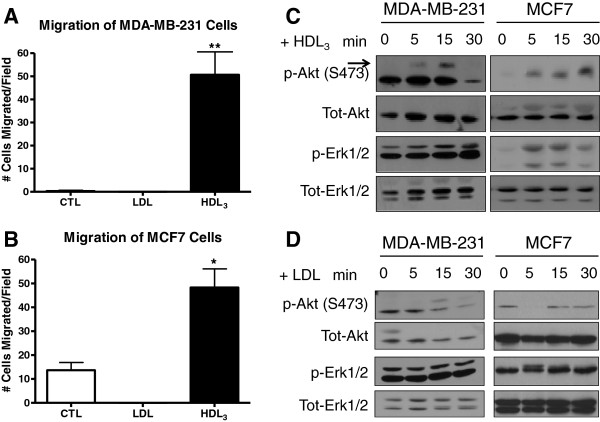
HDL3 induces migration and acts as a signaling molecule in MDA-MB-231 and MCF7 cells.  Migration of MCF7 (A) and MDA-MB-231 (B) cells was induced by HDL3. Migration of MCF7 and MDA-MB-231 cells was increased when HDL3, but not LDL, was used as a chemoattractant compared with CTL (1% BSA alone) in Boyden Chamber assays. Stained cells were quantified by using phase-contrast microscopy. Columns represent the mean number of migrated cells; bars represent ± standard deviation (SD) (n = 3). The results obtained with CTL and HDL3 groups are significantly different. No statistical difference was found between CTL and LDL groups. (A) *P < 0.05, Student's t test. (B) **P < 0.01, versus 1% BSA by Student's t test). Results shown are representative of three independent experiments. (C). MDA-MB-231 and MCF7 cells were incubated for the indicated amounts of time with 100 μg/ml HDL3. Whole-cell lysates were analyzed by Western blotting for the indicated proteins. The arrow indicates the protein corresponding to phospho-Akt. Results are representative of three independent experiments. (D) MDA-MB-231 and MCF7 cells were incubated for the indicated amounts of time with 100 μg/ml LDL. Whole-cell lysates were analyzed by Western blotting for the indicated proteins. The arrow indicates the protein corresponding to phospho-Akt. Results are representative of three independent experiments.